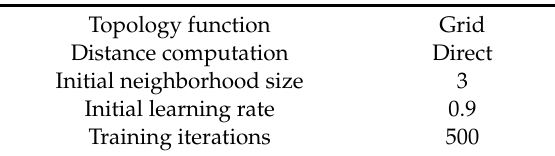
Figure 13. The structure of the Kohonen self-organizing feature map for infrared image segmentation. Table 1. Training